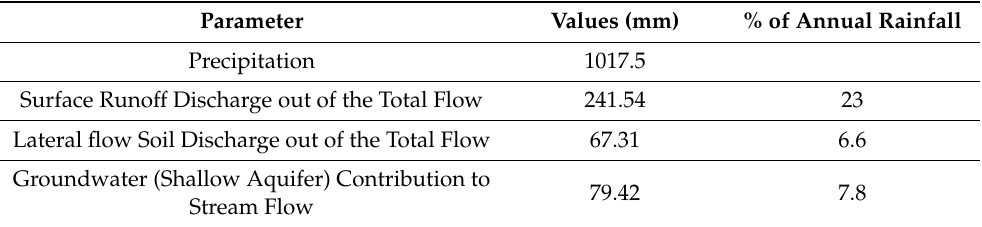
Table 5. Average long-term annual water balance of the calibrated SWAT model in the study catchment. Parameter Values (mm) Precipitation Surface Runoff Discharge out of the Total